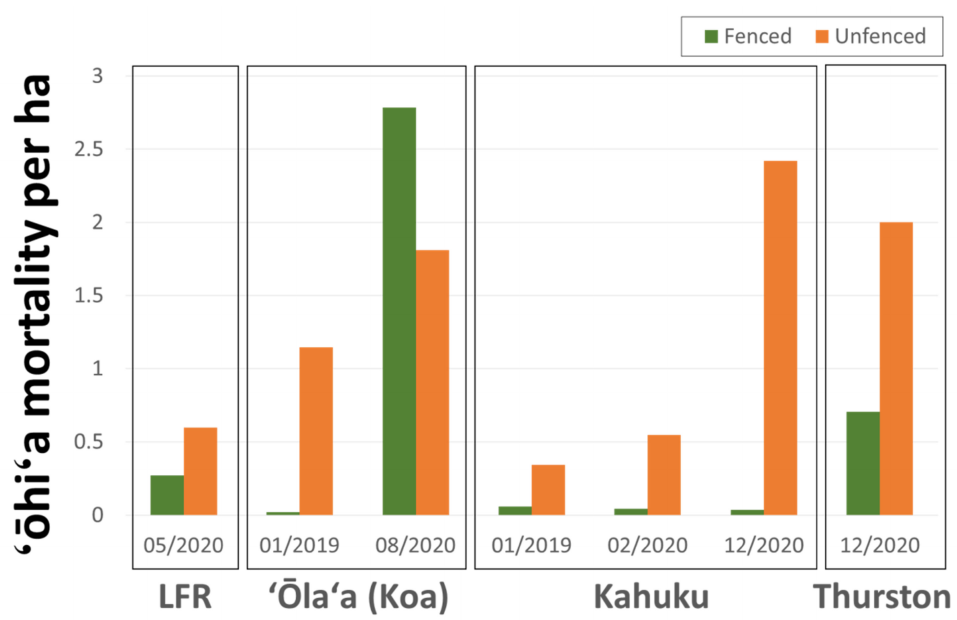
Figure 9. Observed ‘¯ohi‘a mortality densities for fenced and unfenced areas for the four study